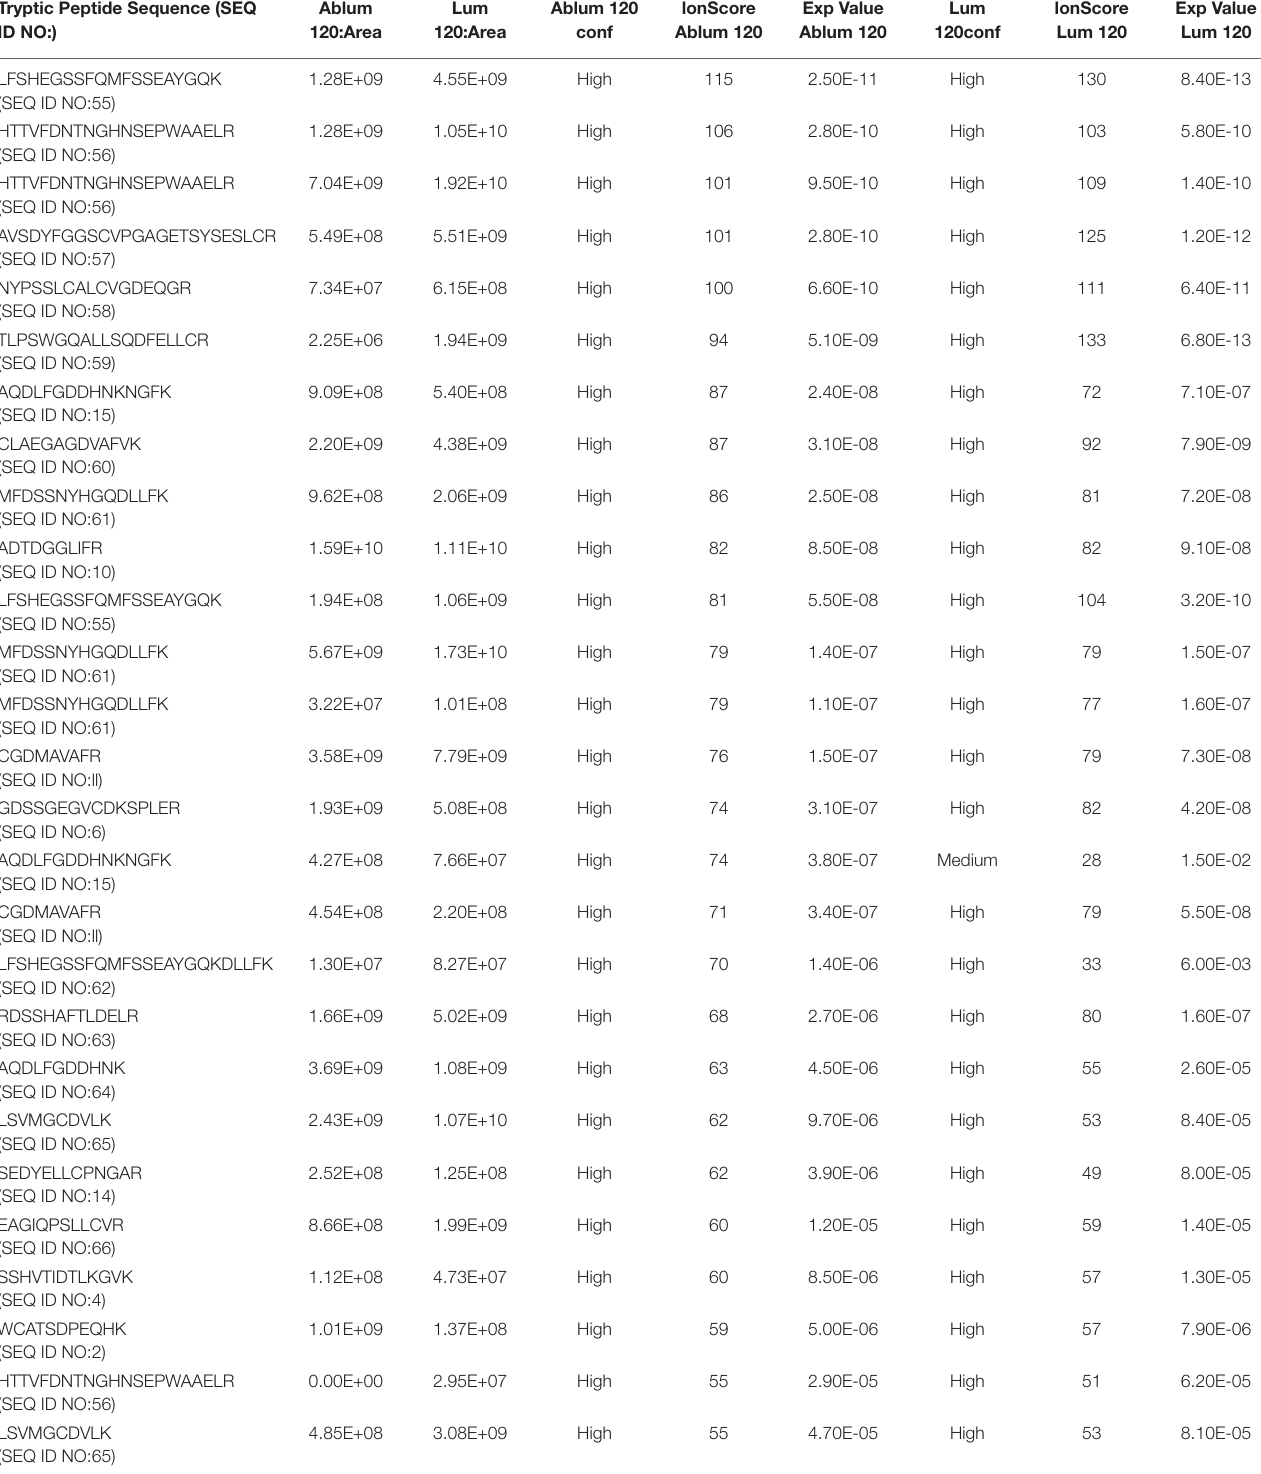
TABLE 1 | Soluble melanotransferrin tryptic peptides at 3 micron pore size. Tryptic Peptide Sequence (SEQ ID NO:)